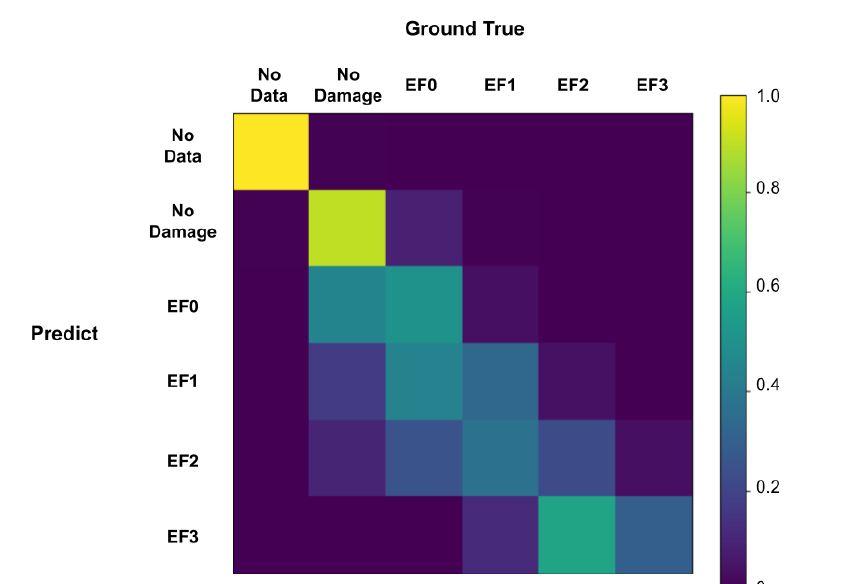
Figure 11. Normalized confusion matrix of averaged-and-discretized rasters. The elements are normalized over ground truth (rows) [47].